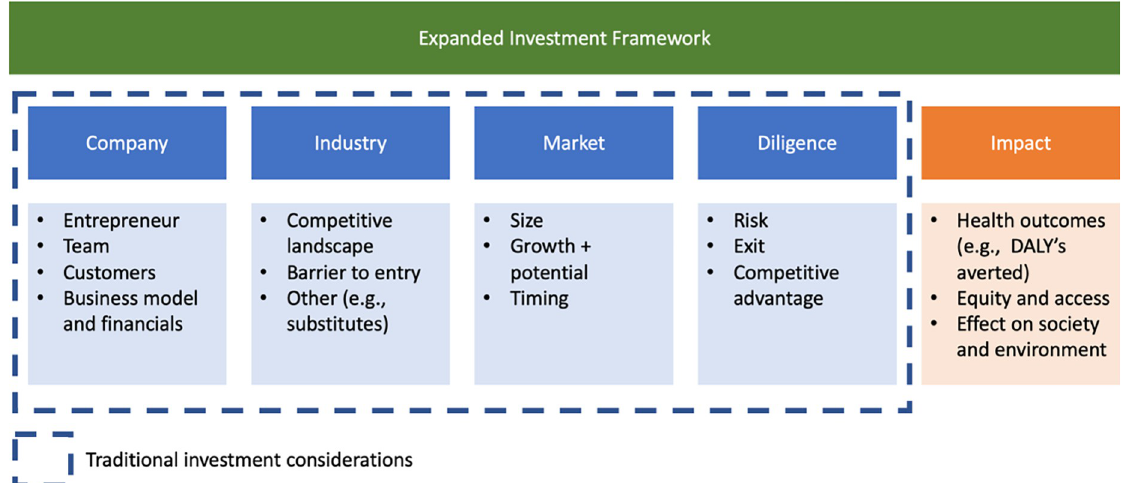
Fig 1. Expanded investment framework. This expanded investment framework is a tailored form of impact investing that goes beyond traditional factors (e.g., profit) to include health outcomes among other outcomes (such as impact on the environment). The traditional investment framework is representative but not exhaustive and demonstrates many of the factors that venture capital and private equity investors typically consider when investing in digital tools. Each specific investor may prioritize different aspects of this framework and may even consider other factors too. It is likely that publicly backed funds/research funding consider very different criteria as well. The traditional investment model is adapted from references [35,